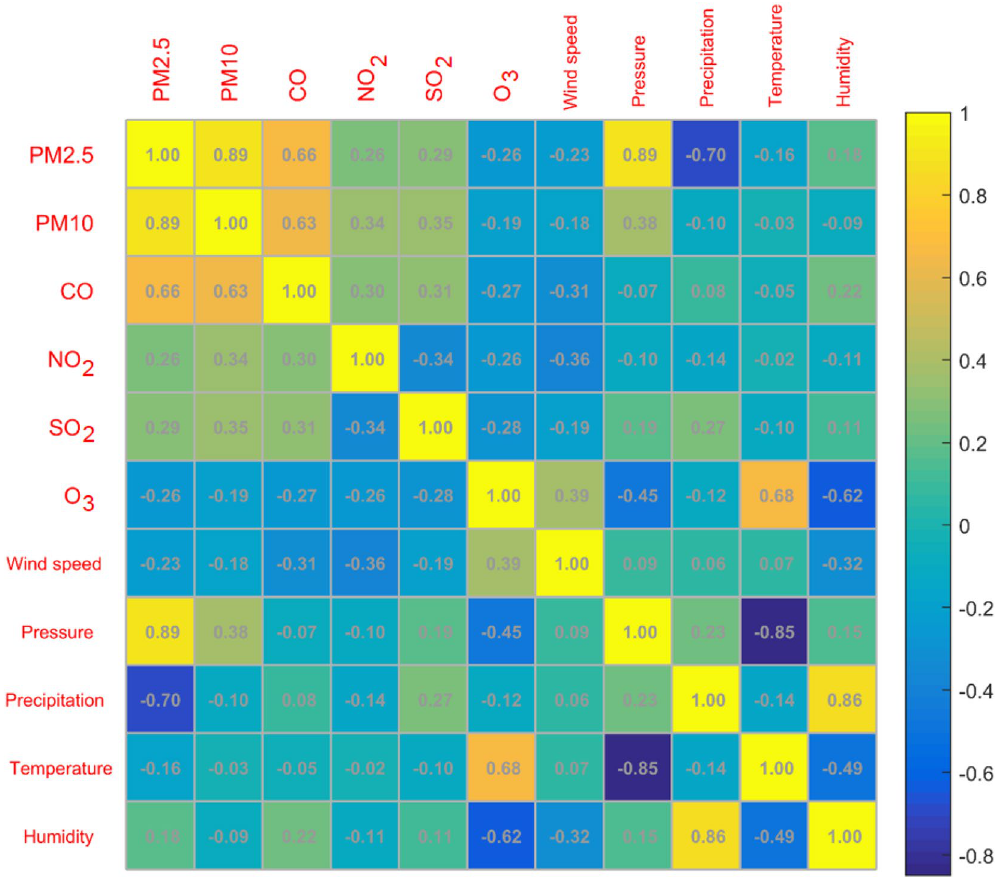
Figure 3. Pearson correlation coefficient matrix color block diagram between the concentration of “two dust and four gases” and climate